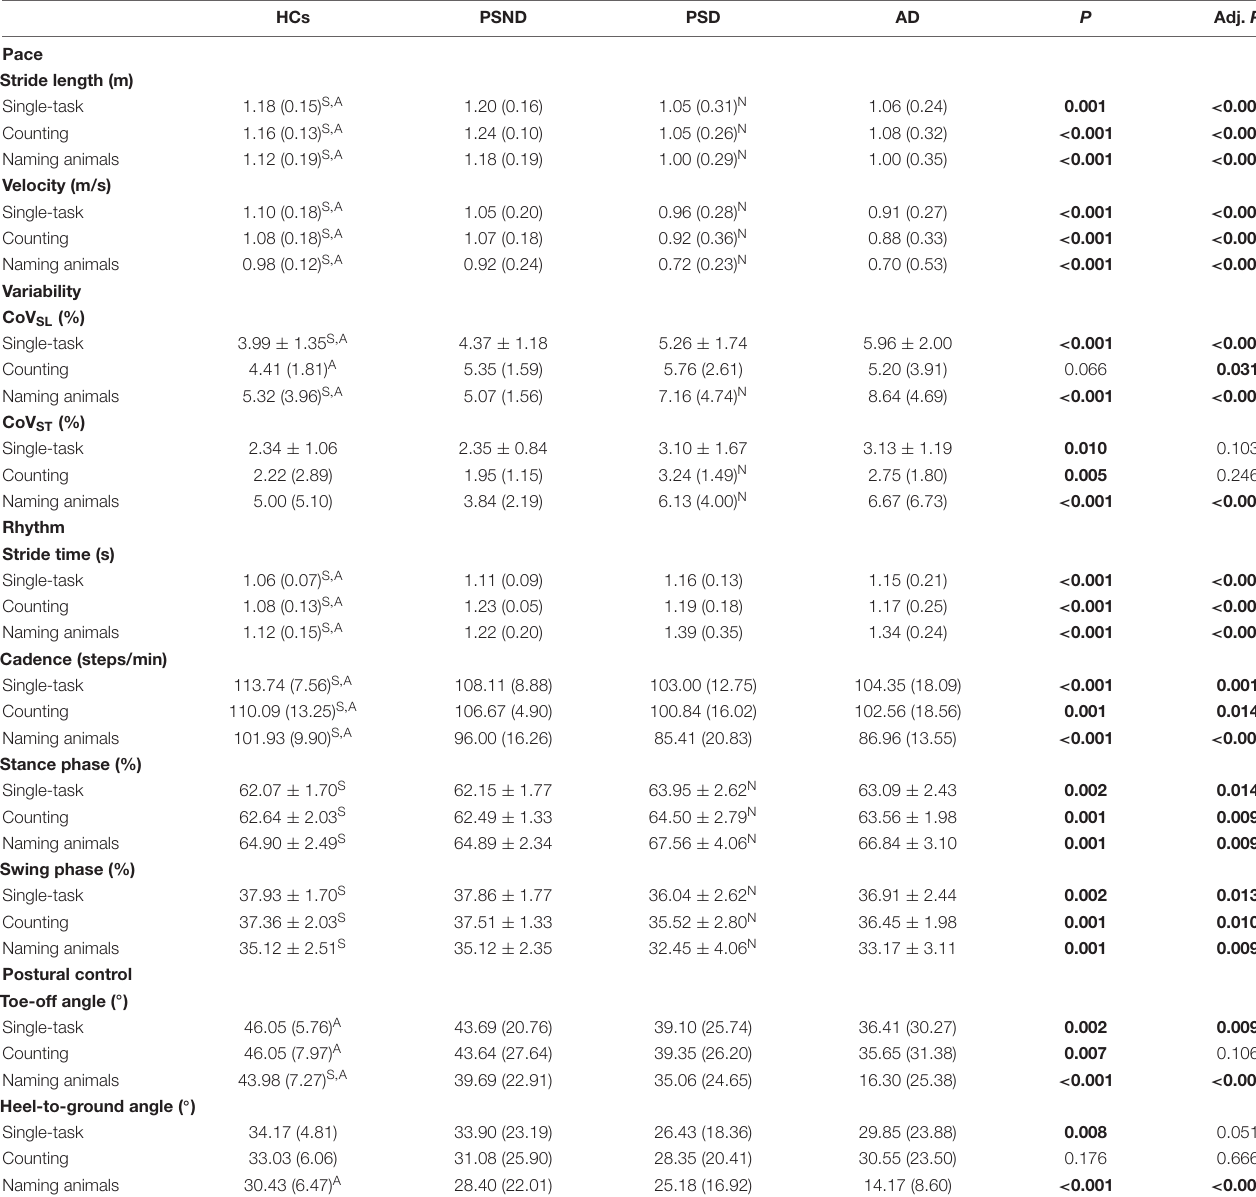
TABLE 2 | Comparison of gait characteristics among controls, non-dementia post-stroke, and dementia subtypes. HCs PSND PSD AD Adj.